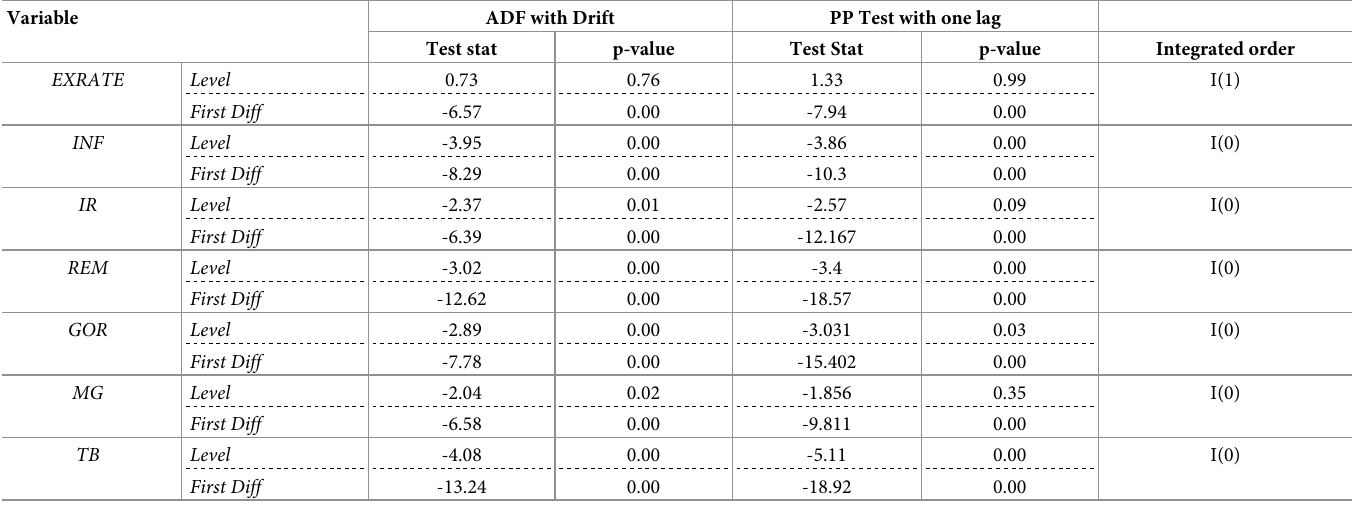
Table 7. Stationarity test of the variables.